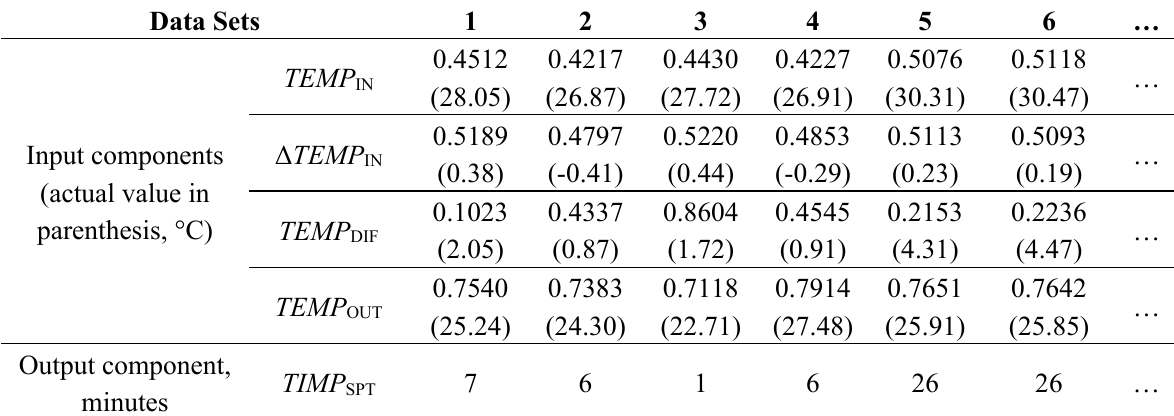
Table 3. Composition of the training datasets.